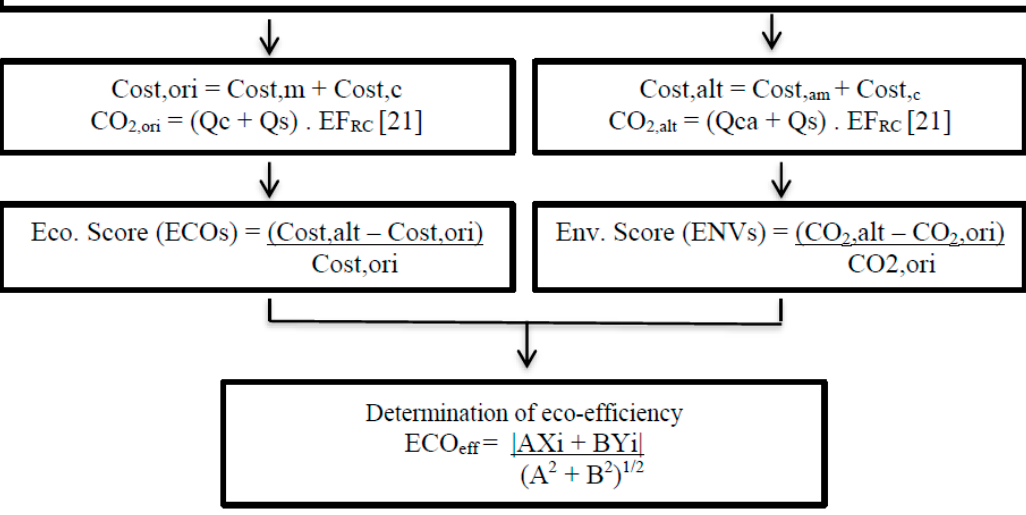
Figure 1. Flow chat determination of eco-e ffi ciency